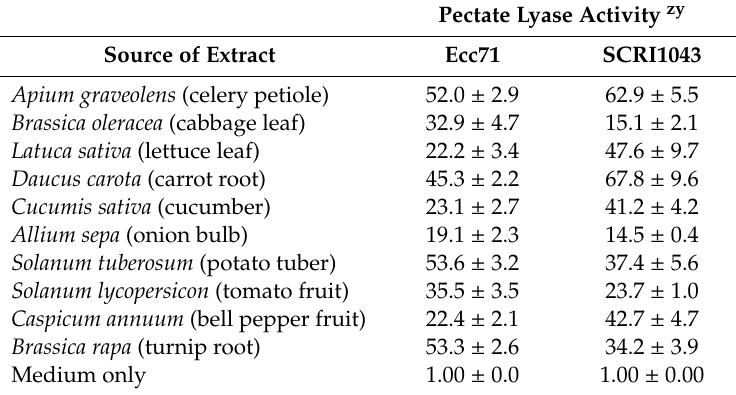
Table 1. Induction of pectate lyase activity by filtered extracts from di ff erent